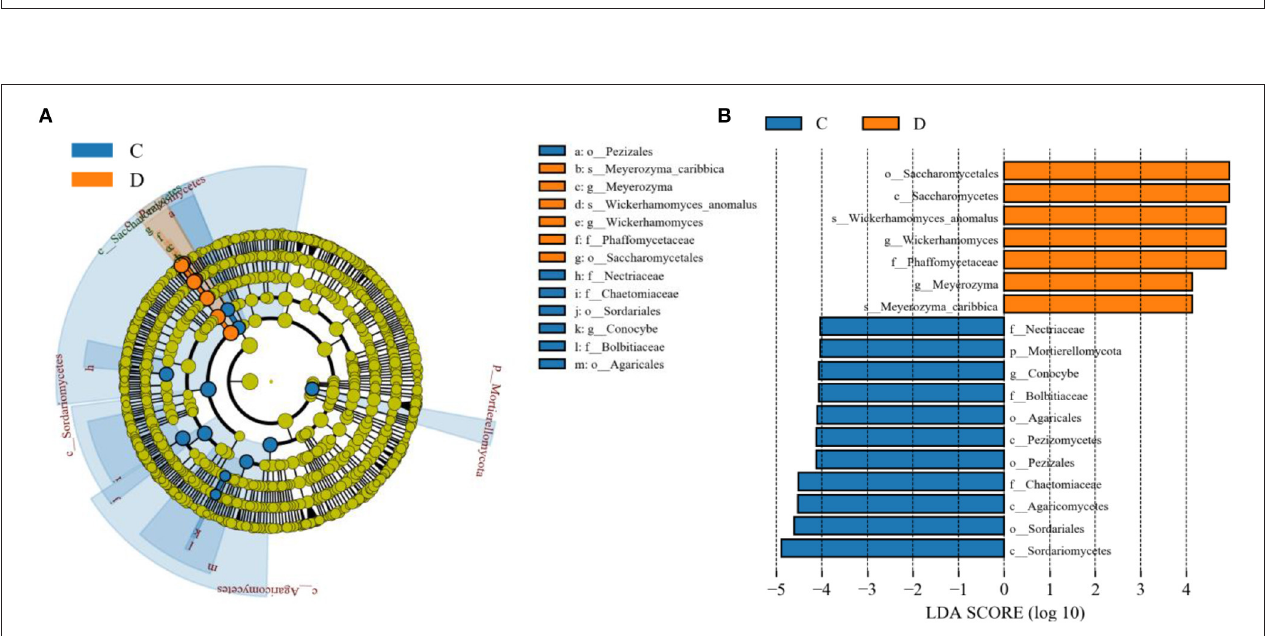
FIGURE 8 | Effect size (LEfSe) analysis of intergroup samples. (A) LEfSe cladogram of fungal communities between the two groups. (B) Distribution histogram based on line discriminant analysis (LDA) value (LDA scores > 4).